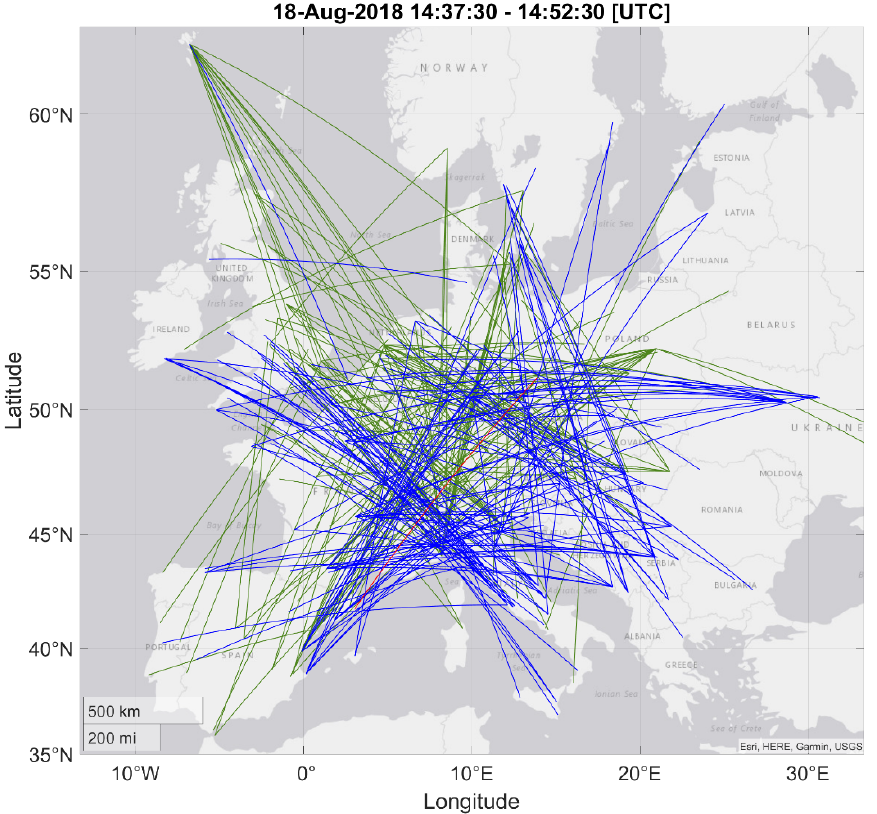
Figure 2. Example map showing reception reports from a 15 min period centered on 14:45 UTC 18 August 2018. Solid lines indicate the great circle paths between the transmitting and receiving stations. Green = 28 MHz, blue = 50 MHz, red = 70 MHz.